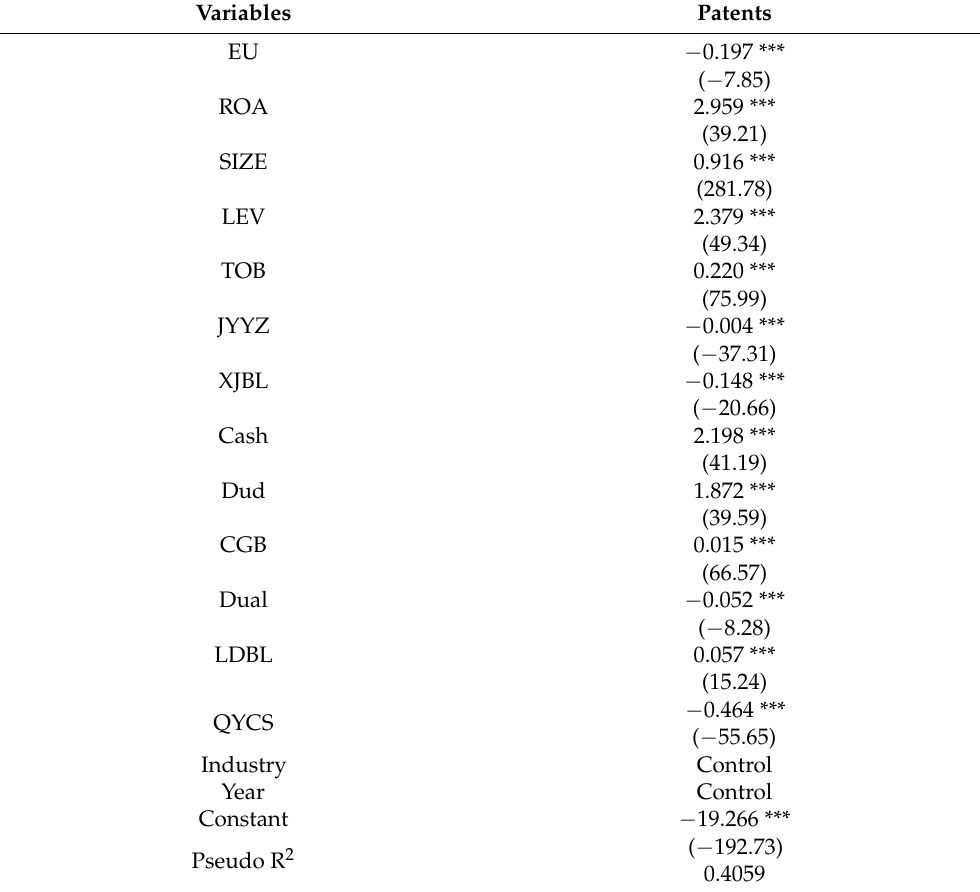
Table A4. Poisson regression (panel